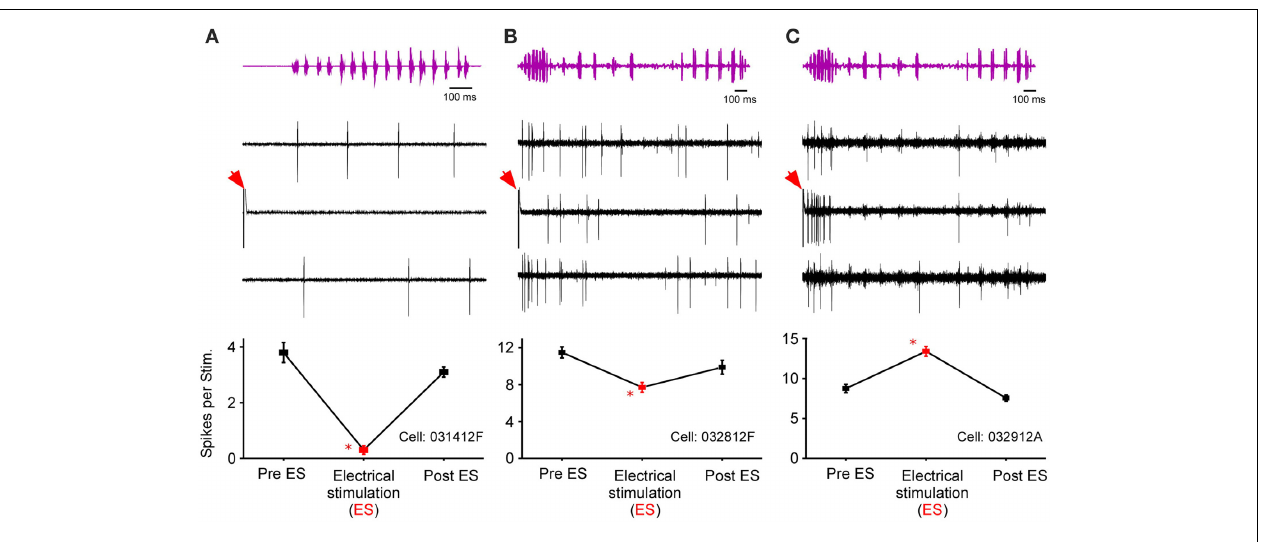
FIGURE 6 | Responses of three cells to call stimuli before, during, and after thalamic stimulation. Top row shows the time waveform for the calls [ (A) , snore; (B , C) , Grunt-Chuckle]. Middle row shows voltage traces for the